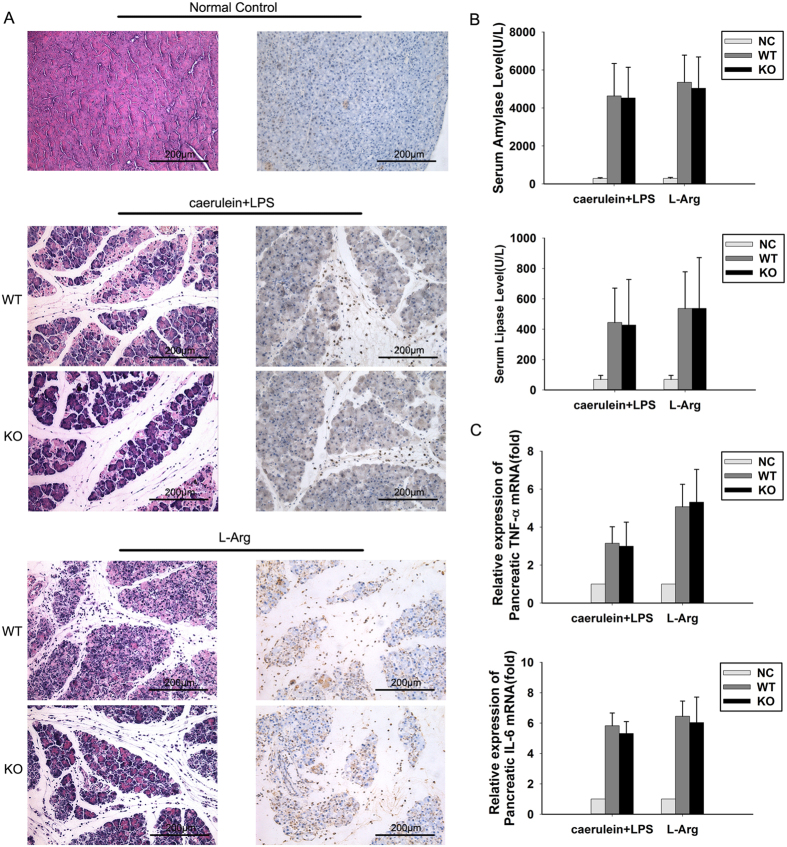
JAM-C knockout does not alleviate murine experimental pancreatitis.(A) Representative micrographs show no significant differences in pancreatic injuries between JAM-C-deficient mice and wild-type mice in caerulein plus LPS or L-Arg induced pancreatitis. Left row: H & E sections; Right row: immunohistochemical analysis of neutrophil infiltration by Ly-6G antibody. No significant differences were observed in the activities of serum amylase or lipase (B) or in the mRNA levels of IL-6 and TNF-α in pancreatic tissues (C). NC: normal control, WT: wild-type mice, KO: JAM-C knockout mice. n = 4~11. Original magnification ×200. Mice were sacrificed 12 h after the first caerulein injection or 3 d after the first L-arginine (L-Arg) injection.